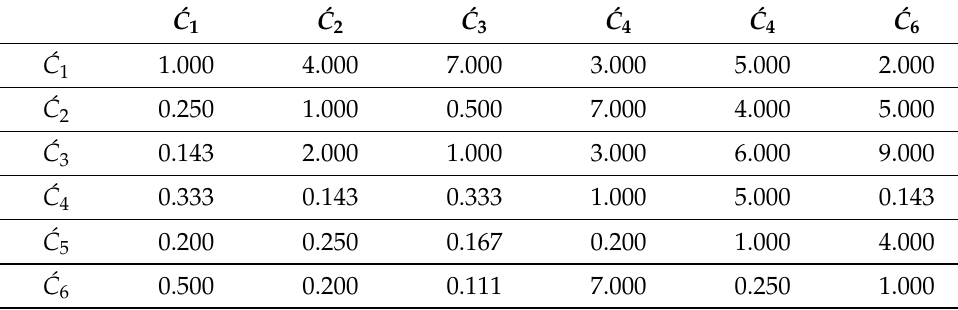
Figure 4. Flow chart of Algorithm 2 for AHP-TOPSIS. Table 9. Pair-wise comparison